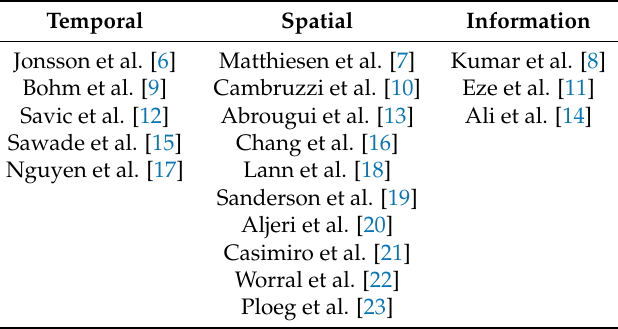
Table 1. Results classification according to redundancy